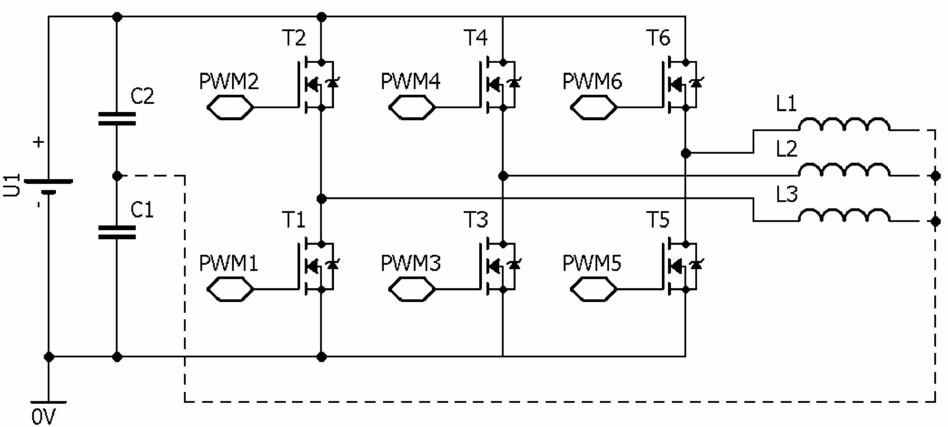
Figure 5. Circuit schematic of three-phase DC/AC